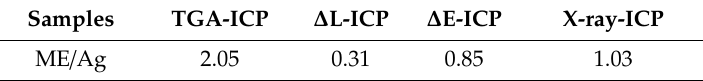
Table 2. Mean squared error (Equation (5)) of the di ff erent values obtained for the AgNPs contents of ME / Ag foams using 0.85 and 1.70 mg / mL as solution precursor, as well as the di ff erent reaction